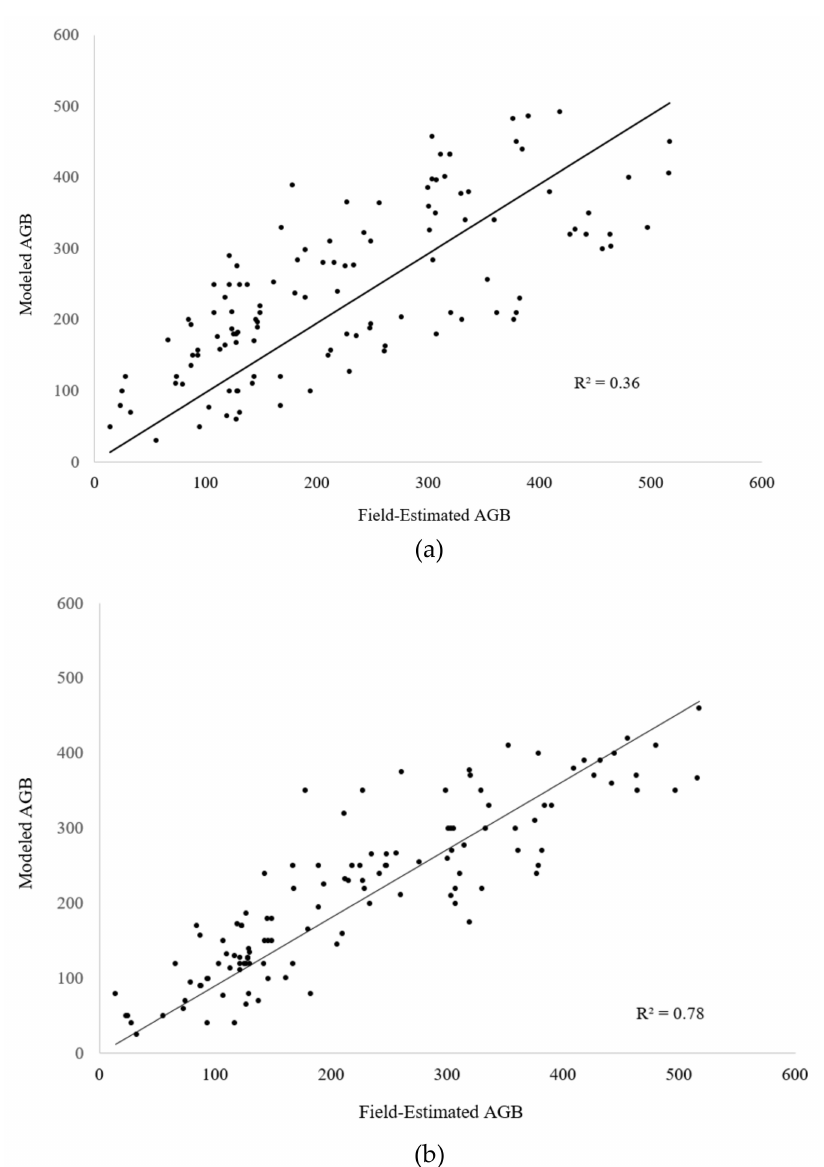
Figure 14. Relationship between the field-estimated AGB and the modeled AGB: ( a ) before POA compensation, and ( b ) after POA